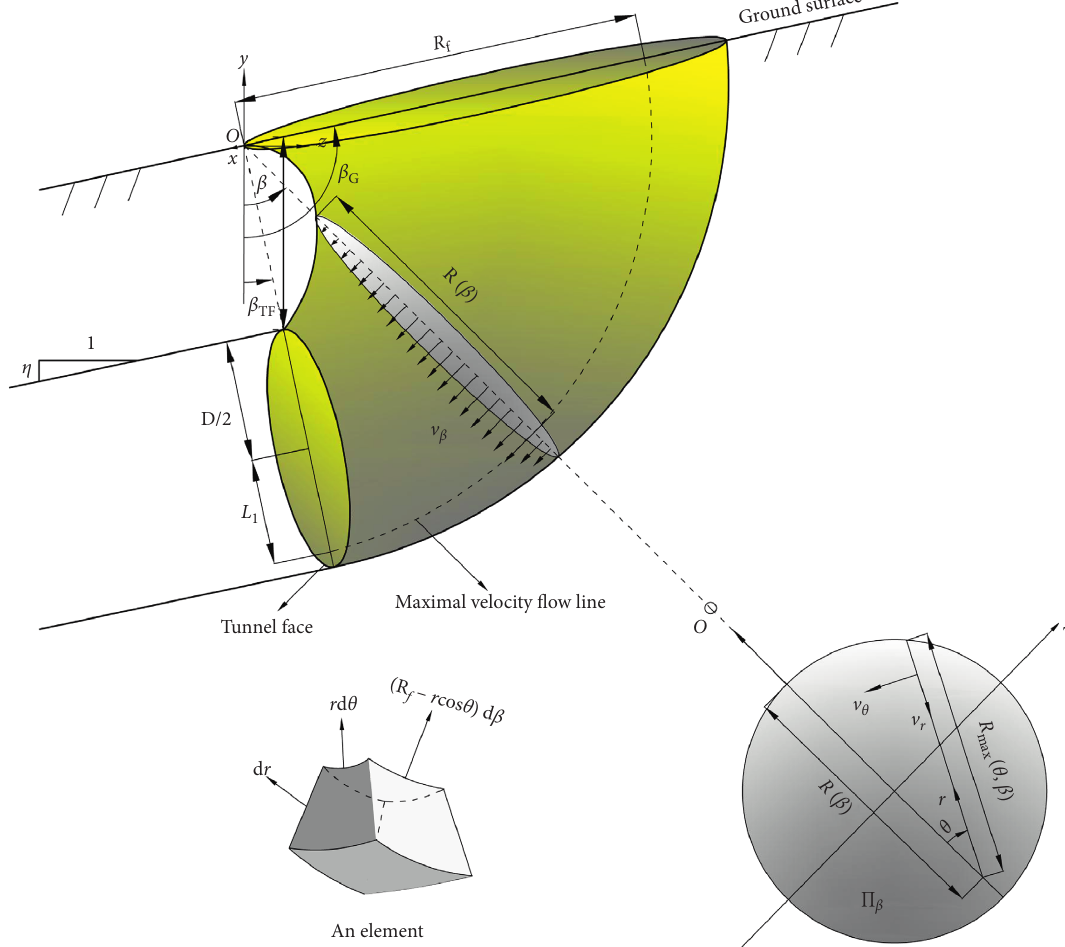
Figure 2: Continuous velocity field for the undrained failure of the tunnel face with a longitudinal gradient.